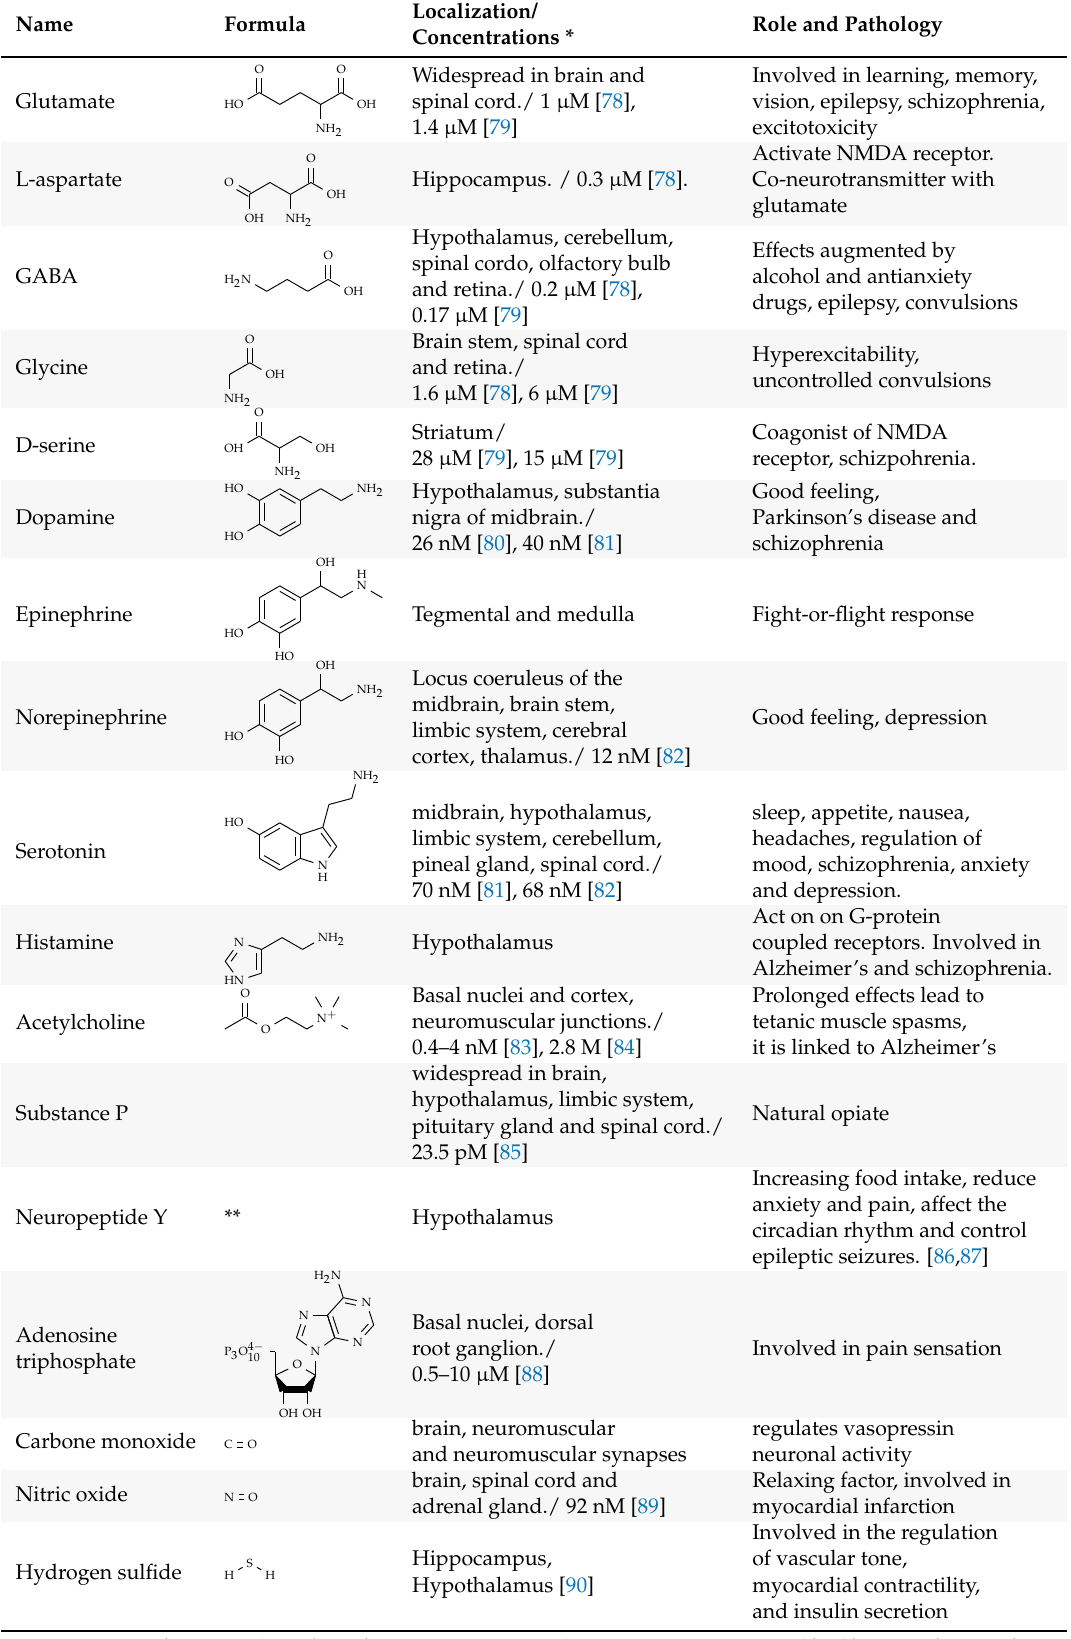
Table 1. Summary of major